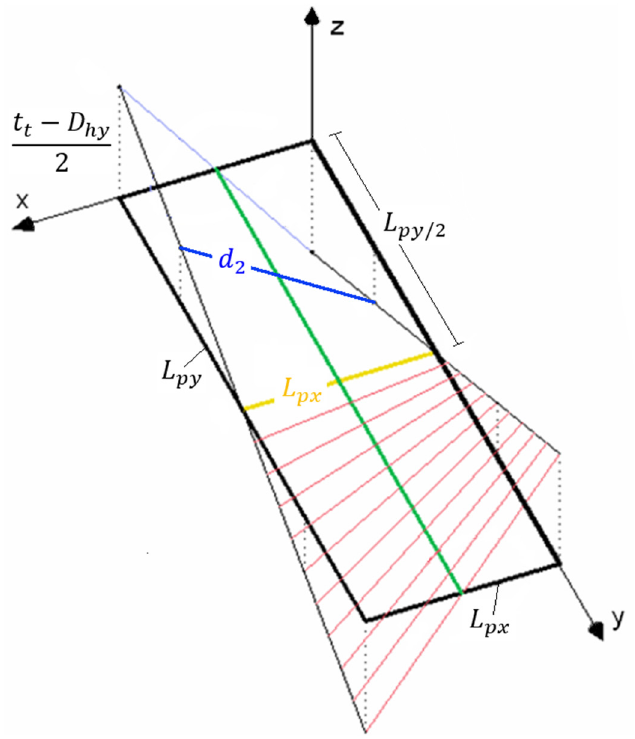
Figure 5. Graphic definition of the generatrix d 2 .